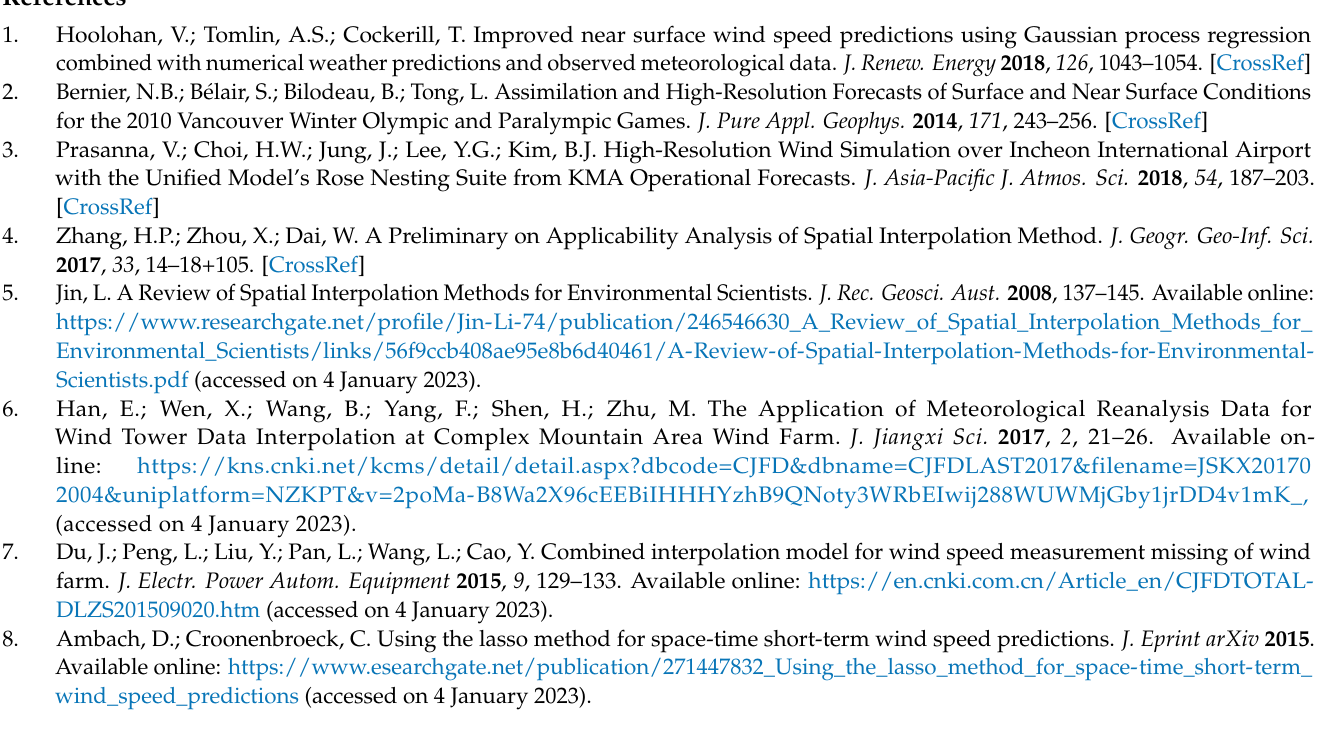
on the summer training sets; Figure S2: Scatterplot for all seven non-linear models on the summer validation sets; Figure S3: Same as Figure S1 but for winter training sets; Figure S4: Same as Figure S2 but for winter validation sets; Table S1: Landuse value and